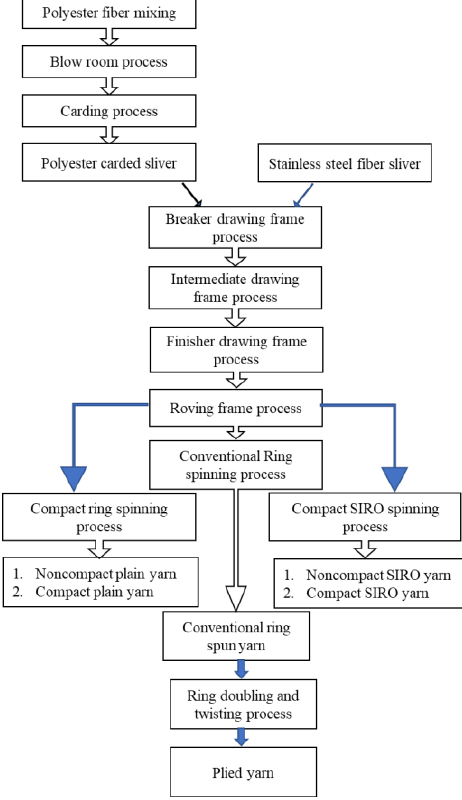
Figure 1. Schematic process flow of yarns produced.